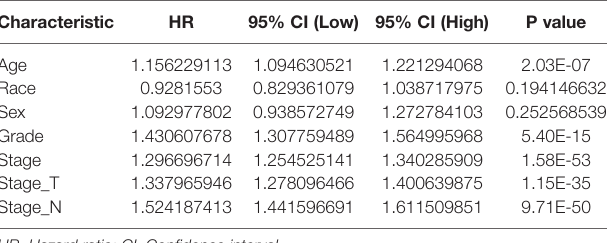
TABLE 2 | Univariate Cox regression analysis of the relationship between clinicopathological features and prognosis in gastroesophageal junction carcinoma patients. Characteristic